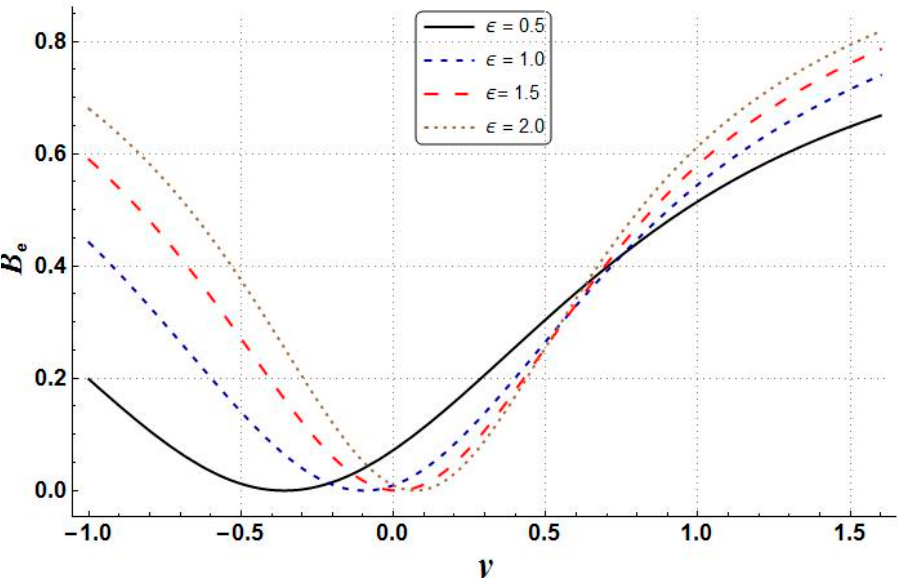
Figure 33. Influence on B e through changing values of ∈ , where γ = π φ = 0.05, k = 2, a = 0.6, M = 1, d = 0.7, Br = 0.2, b = 0.5, m = 1, η = 0.8.